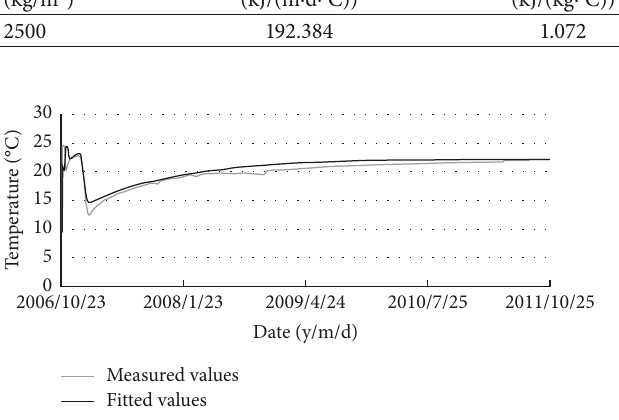
Figure 9: Historic curve of temperatures of block